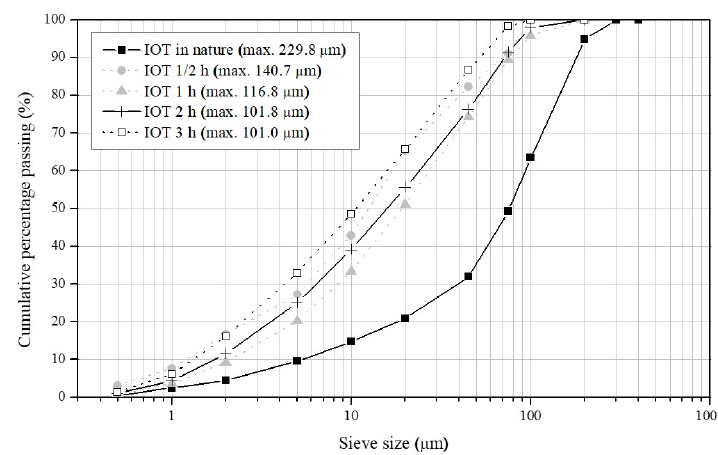
Figure 3. Grading of iron ore tailings.